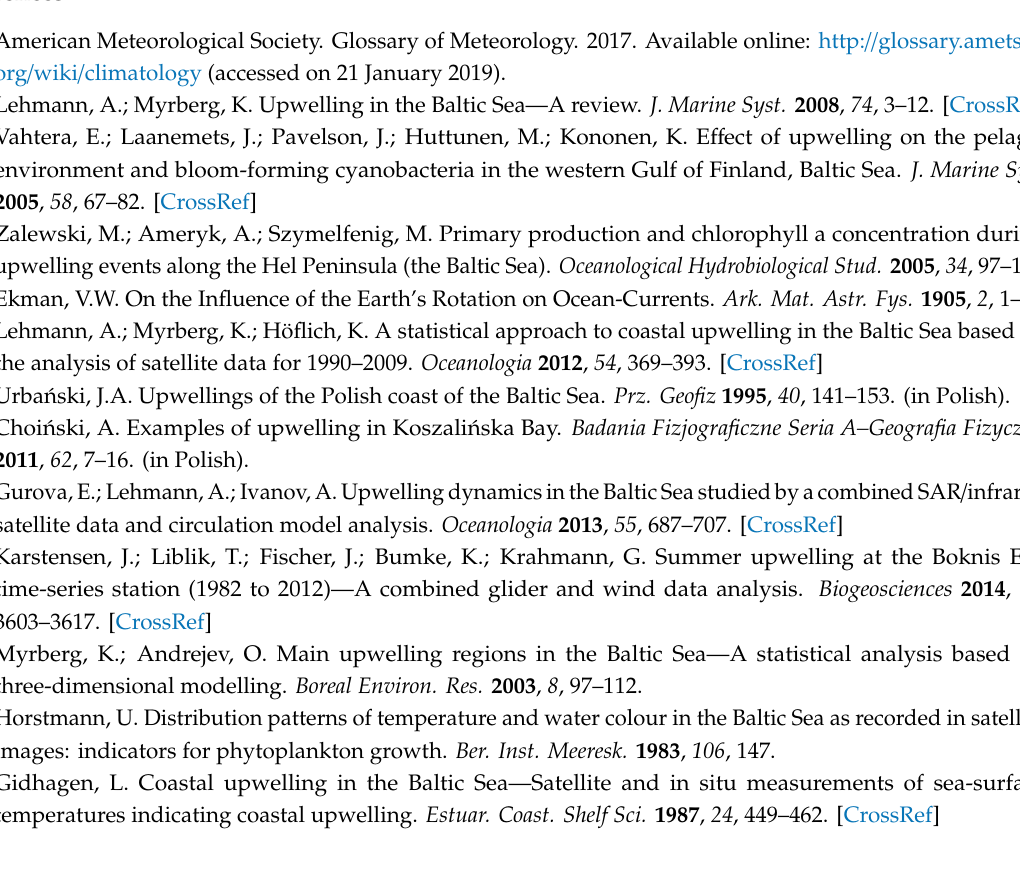
Figure A2. Anomalies of SLP in positive (left) and negative (right) phase of zonal (Z) and meridional (M) local circulation pattern based on the first (negative phase) and the third (positive phase) quartile.